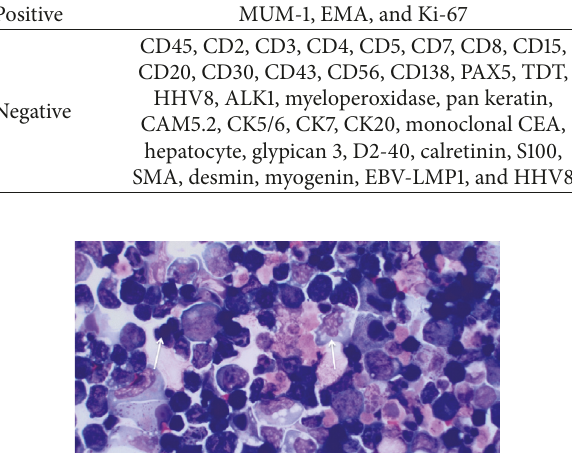
Table 1: Ascitic fluid immunohistochemical staining results. Positive